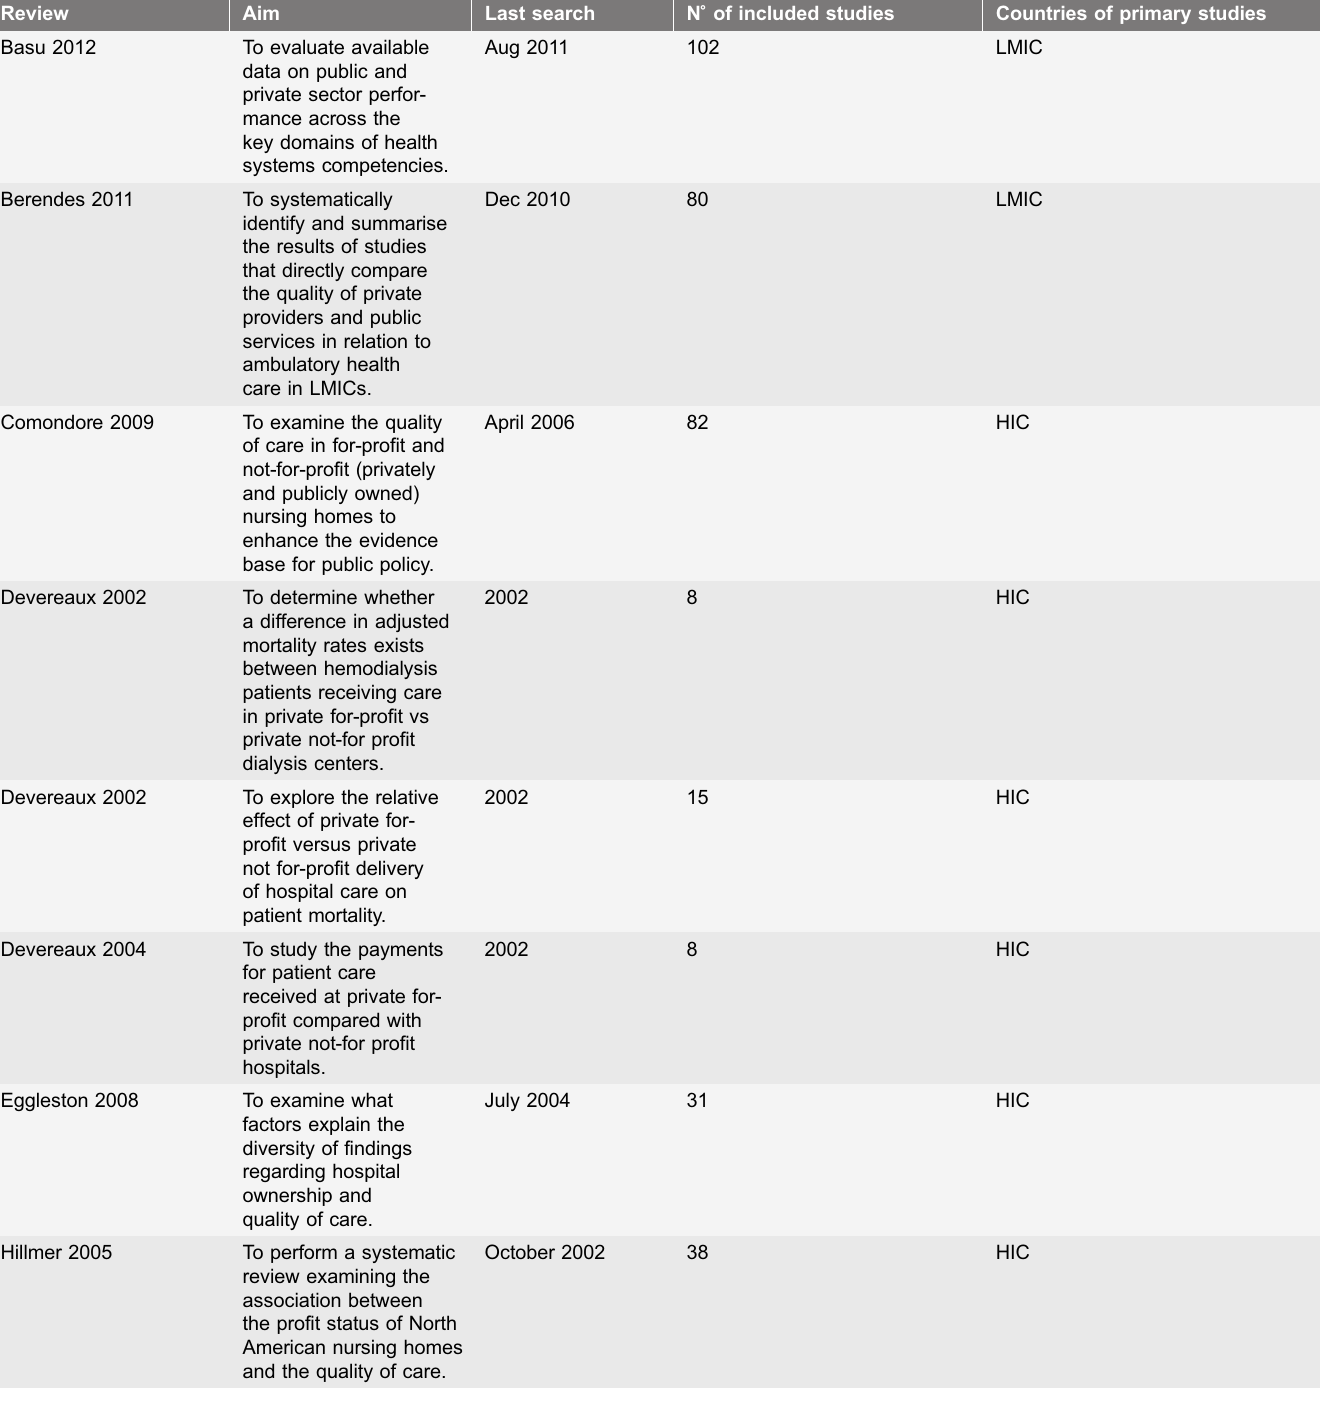
Table 1. Scope of the included systematic